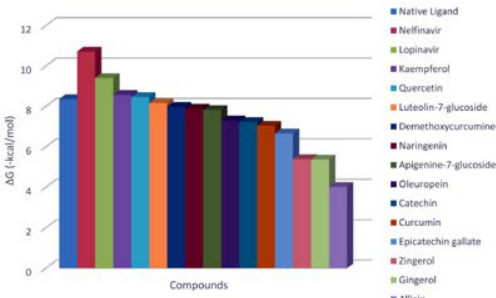
Fig. 9. Histogram of binding energy (ΔG) of potent drugs Reproduced with permission from